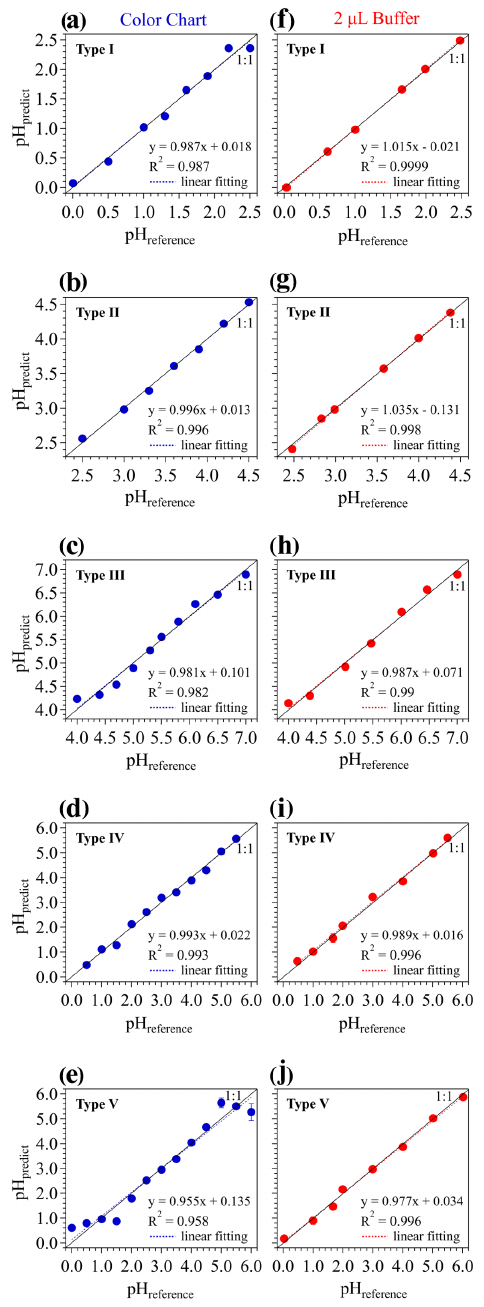
Figure 2. Predicted pH (pH predict ) using our RGB model vs. the reference pH shown on the color chart and the pH-meter-probed- pH of the buffer samples (all denoted as pH reference ) for the five different pH papers: (a, f) type I – 0–2.5; (b, g) type II – 2.5–4.5; (c, h) type III – 4.0–7.0; (d, i) type IV – 0.5–5.5; and (e, j) type V – 0–6.0. Blue symbols denote the established relationship based on color charts only. Red symbols represent the results for 2µL of buffer droplets on pH papers. Both vertical and horizontal error bars represent the SD of five to six replicate experiments. Note that the error bars in most of the panels are smaller than the